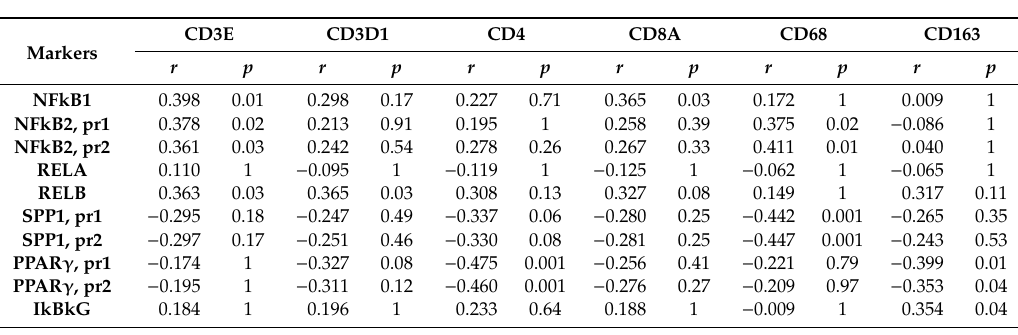
Table 3. Correlation between mRNA expression levels of various NFkB pathway molecules with mRNA expression markers of di ff erent types of infiltrating immune cells. r = two-tailed Spearman